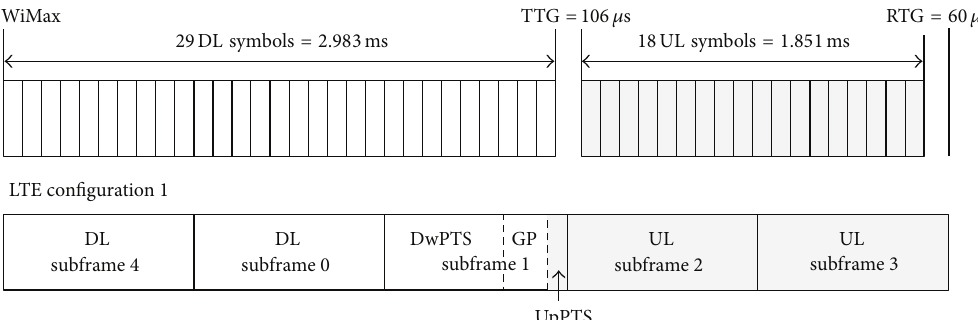
Figure 3: Example of frame synchronization between TD-LTE and WiMax.